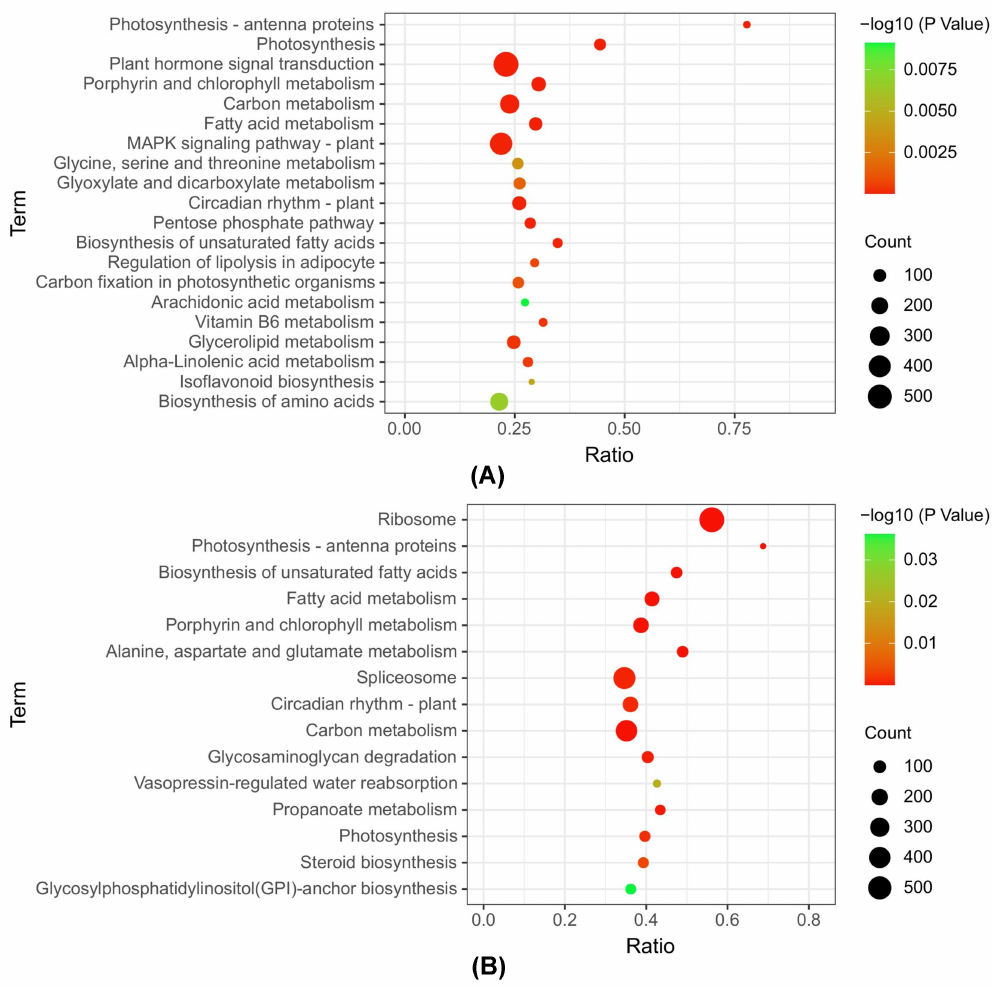
Figure 9. Scatter plots of KEGG pathway enrichment analysis of DEGs in ginseng leaves ( A ) and ginseng stems ( B ).